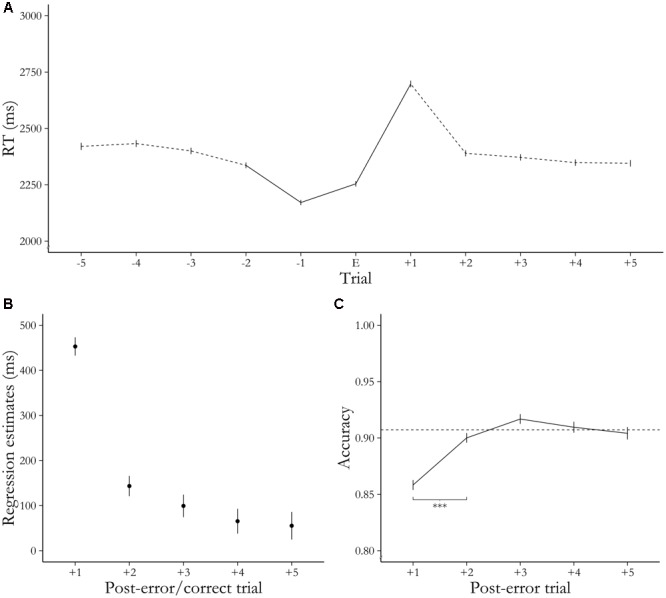
RT and accuracy results. (A) Average RTs on trials pre- and post-error. All trials besides the error are required to be correct trials. Bold line indicates minimal sequence of analysis for an error (CCEC). Error bars represent SEM. (B) Beta estimates indicating the difference between post-error and post-correct trials in RT, depending on distance to error/correct. Error bars represent 95% CI. (C) Average accuracy on post-error trials. Dotted line displays average accuracy over the whole task. Error bars represent SEM. ∗∗∗p < 0.001.